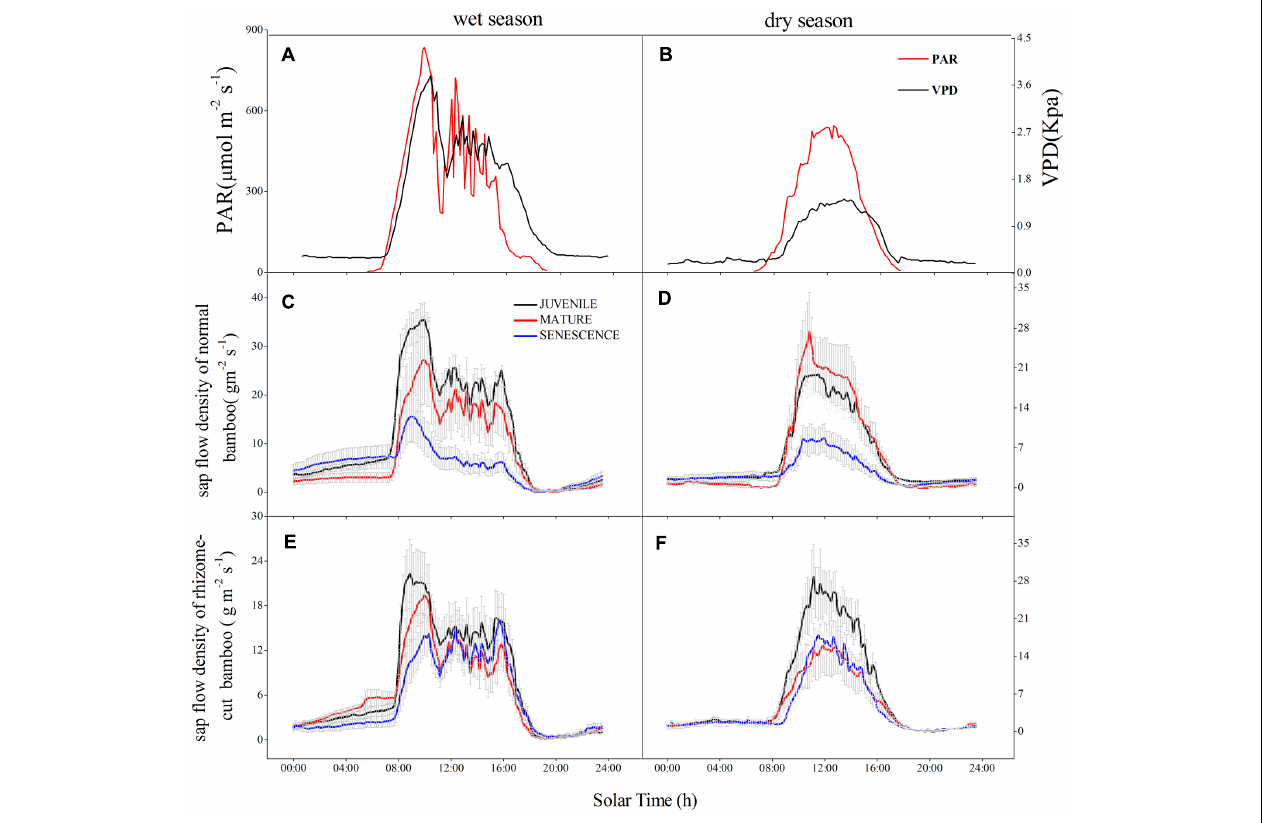
FIGURE 1 | Daily variation of sap flow density ( J s ) in three P. pubescens individuals in wet (28, 29, 30 July) and dry season (26, 27, 28 December). PAR and VPD in the wet (A) and dry (B) seasons; normal bamboo in the wet (C) and dry (D) seasons; rhizome-cut bamboo in the wet (E) and dry (F) seasons.